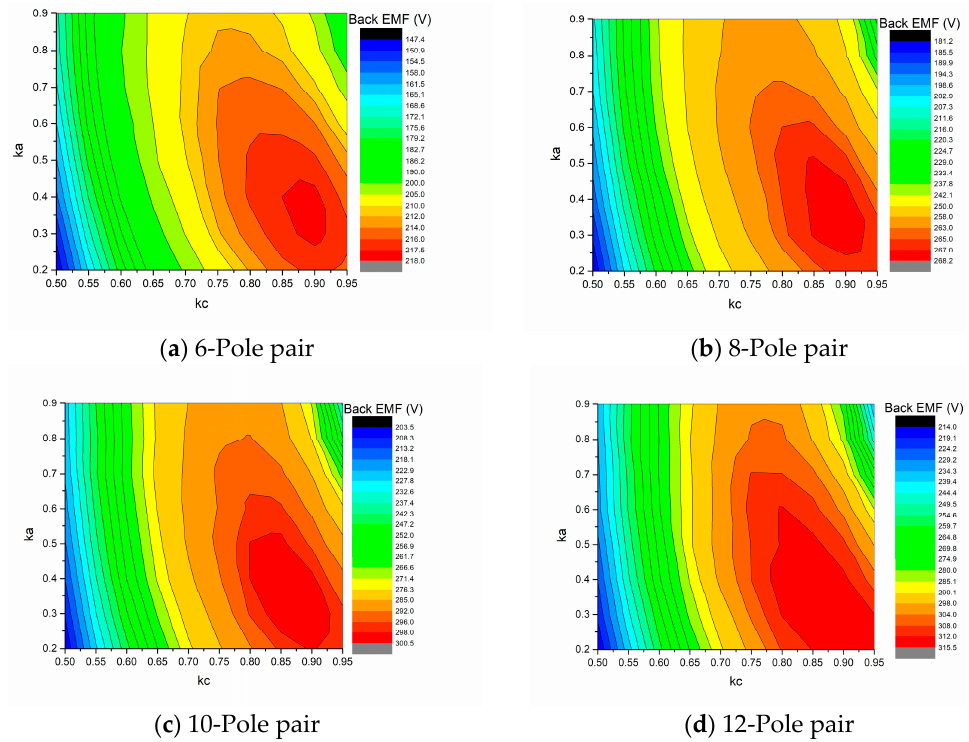
Figure 4. Back EMF of CPM with the variation of the ratio of the pole pitch and the ratio of the claw pole short edge to long